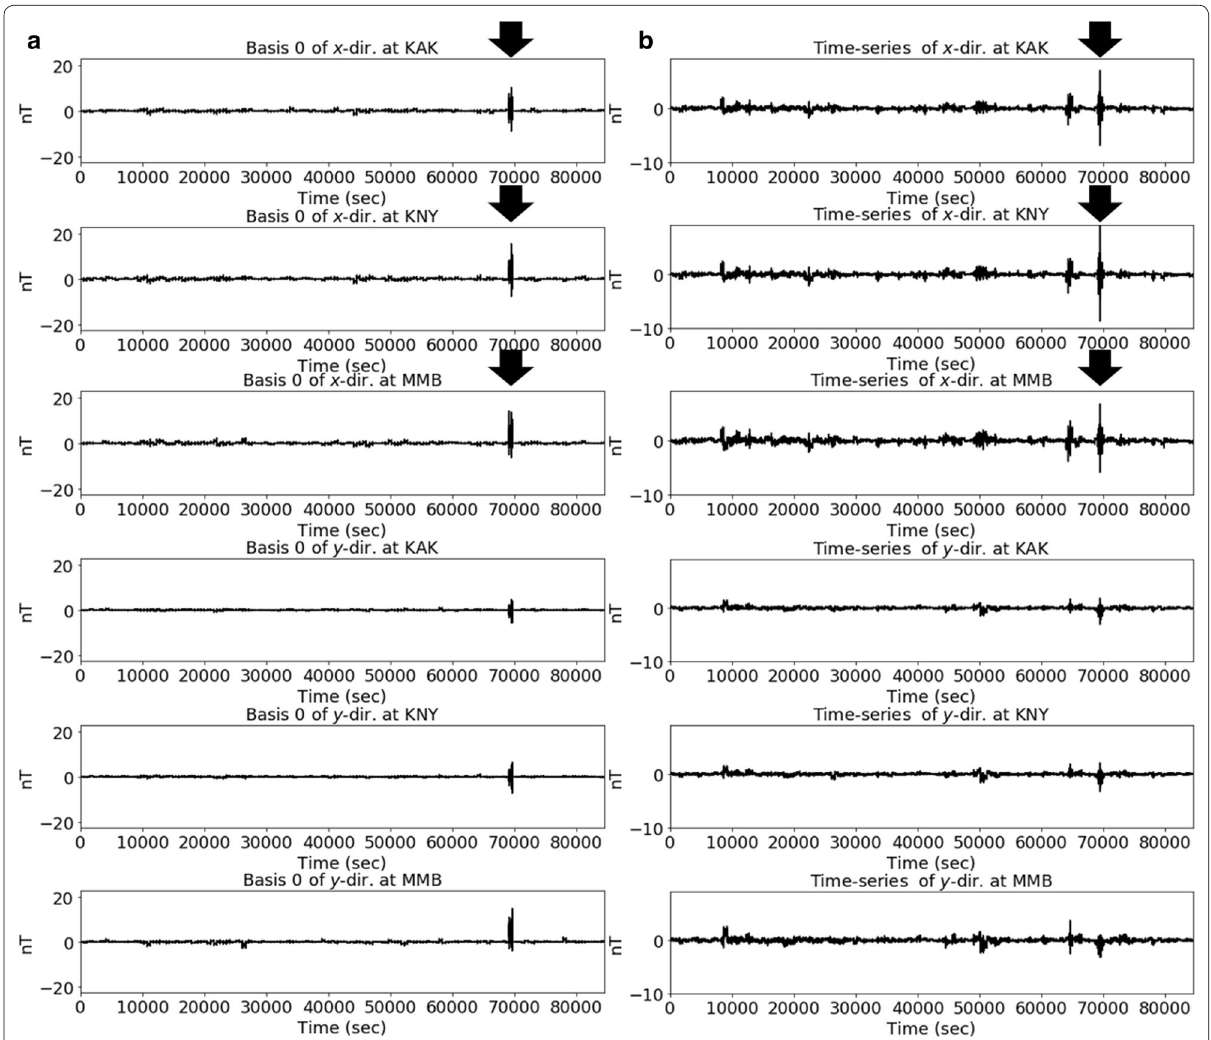
Fig. 5 Comparison of geomagnetic time‑series data at three observatories. a Time‑series data transformed from separated component Y m , d ( 0, f , t ) within the range of 30/30,720–95/30,720 Hz. b Raw time‑series data filtered by a band‑pass filter with the pass band between 30/30,720 Hz and 95/30,720